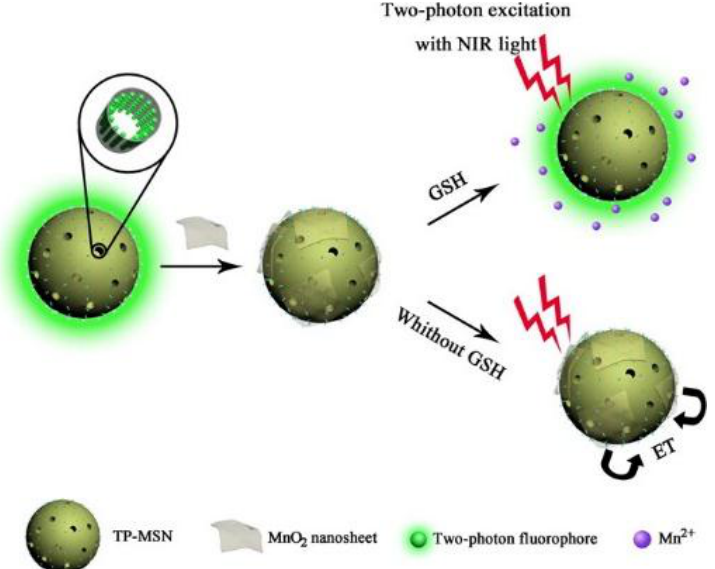
Figure 8. Schematic illustration of two-photon (TP)-MSNs@MnO 2 for glutathione detection. Reproduced with permission from [73]. Copyright 2014 American Chemical Society.